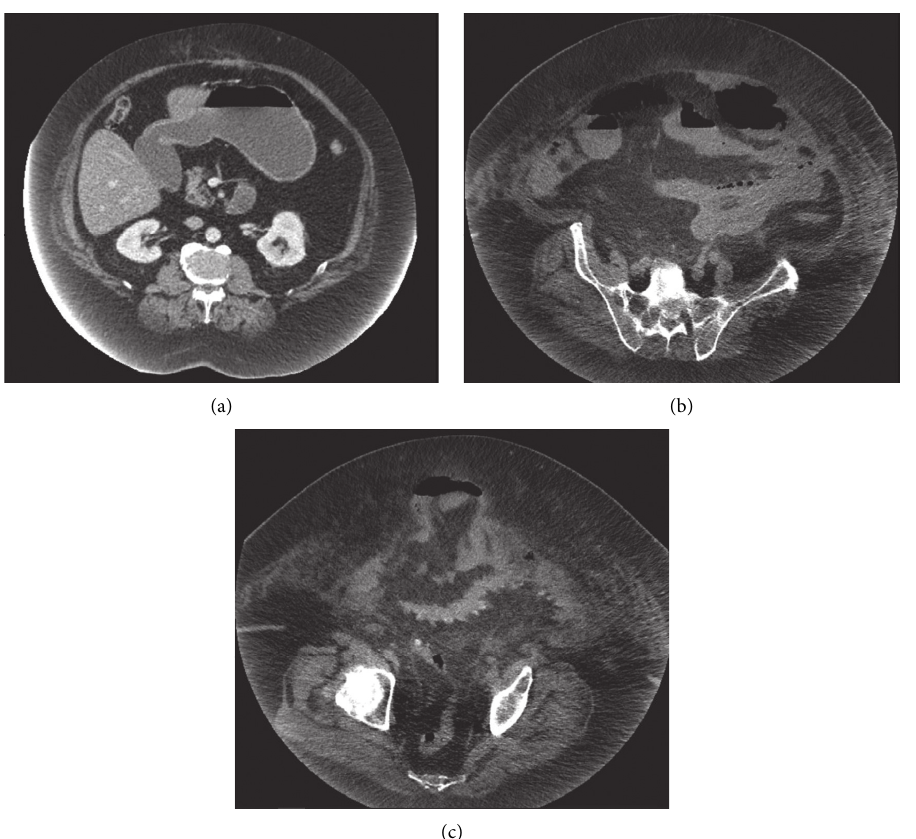
Figure 1: Dilated stomach (a) and small bowel loops throughout the abdomen with a fat-containing ventral wall hernia (b). Umbilical hernia containing fat and distal small bowel loops, transition point